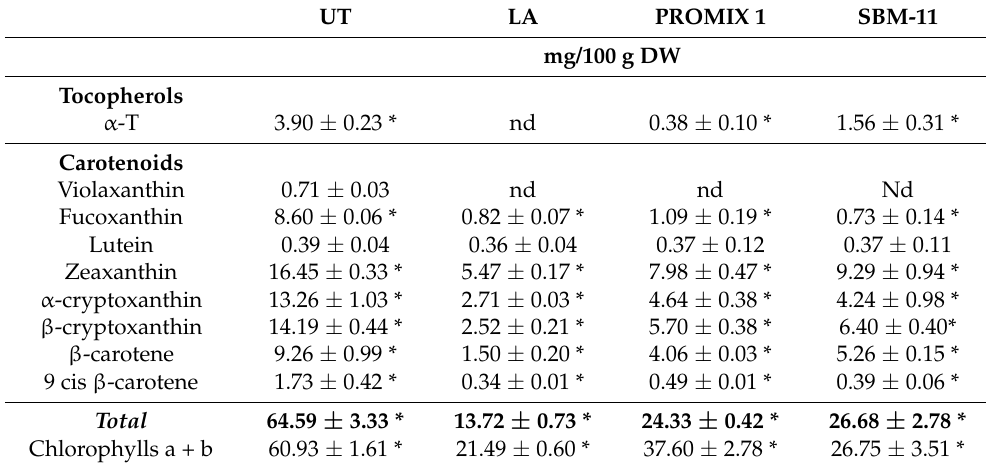
Table 5. Isoprenoid (tocopherols, carotenoids and chlorophylls) composition of untreated control (UT) and in fermented Gracilaria gracilis . LA: Lactobacillus acidophilus ; SBM-11: a mix of Lactobacillus sakei , Staphylococcus carnosus and Staphylococcus xylosus ; PROMIX 1: Staphylococcus xylosus . Data shown is the mean ± SD ( n = 3). Asterisk indicates statistically significant differences ( p < 0.05) between each treatment (LA, PROMIX 1, SBM-11) versus untreated control of Gracilaria gracilis (UT) as determined by the two sample- t -test. UT LA